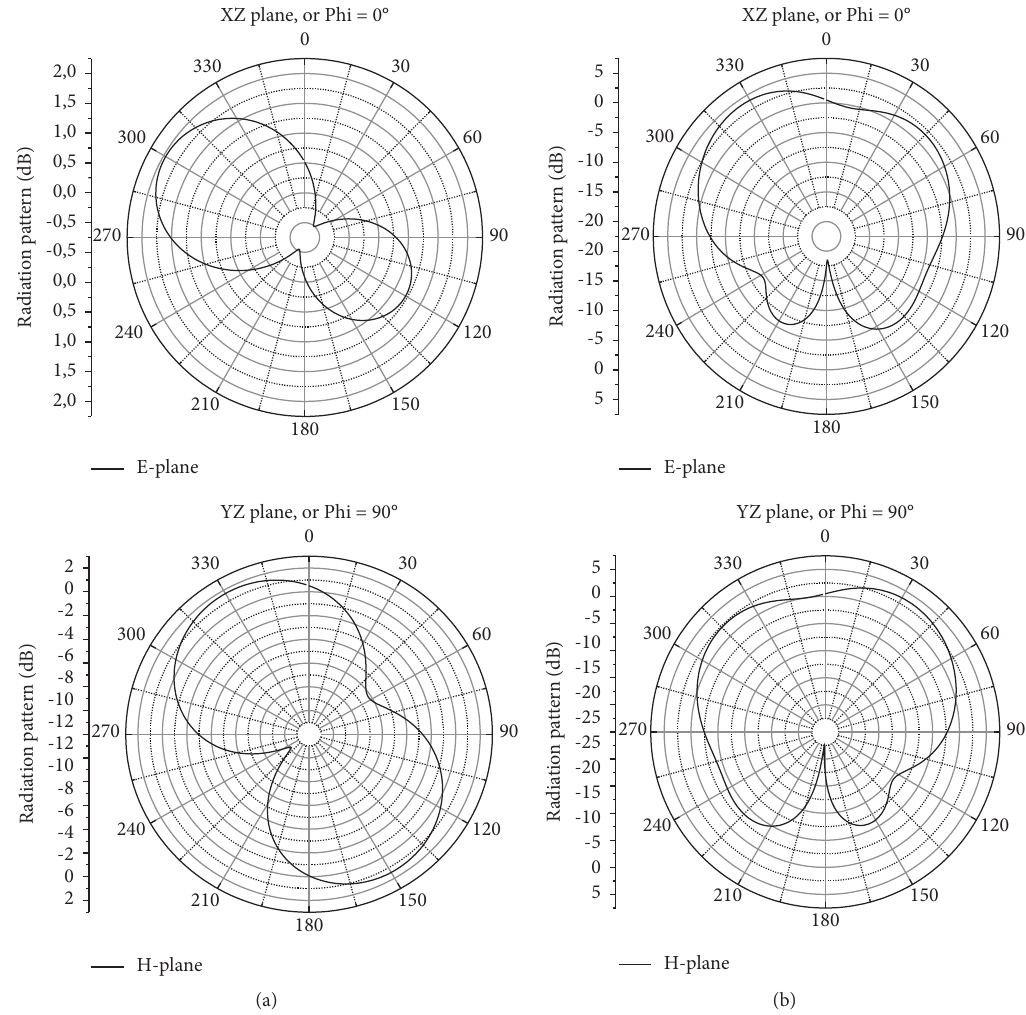
Figure 6: Simulated radiation patterns of the proposed 3D PILA tag antenna when it is placed (a) in the free space and (b) on the 30cm × 30 cm metal plate.